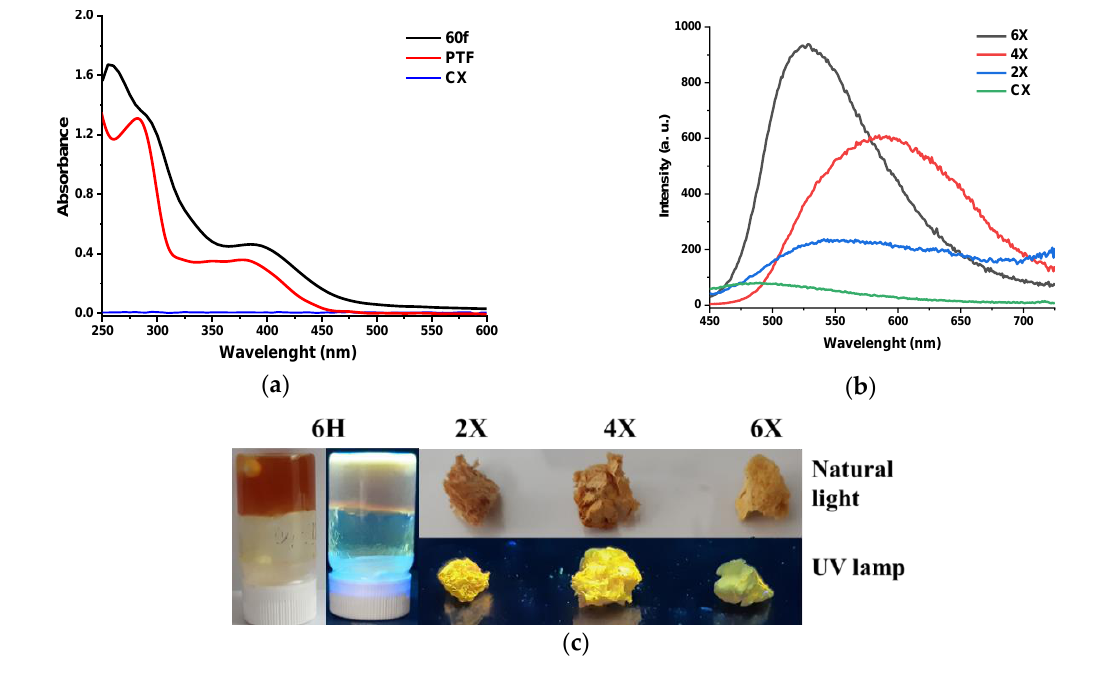
Figure 6. Photophysical behaviour of the samples: ( a ) UV/Vis absorption spectra of a film prepared from chitosan and PTF in a 60/1 molar ratio of amine/aldehyde functional groups (60f) and of chitosan and PTF references; ( b ) emission spectra of the hydrogels and chitosan; and ( c ) images of hydrogels and xerogels when illuminated with a UV lamp.